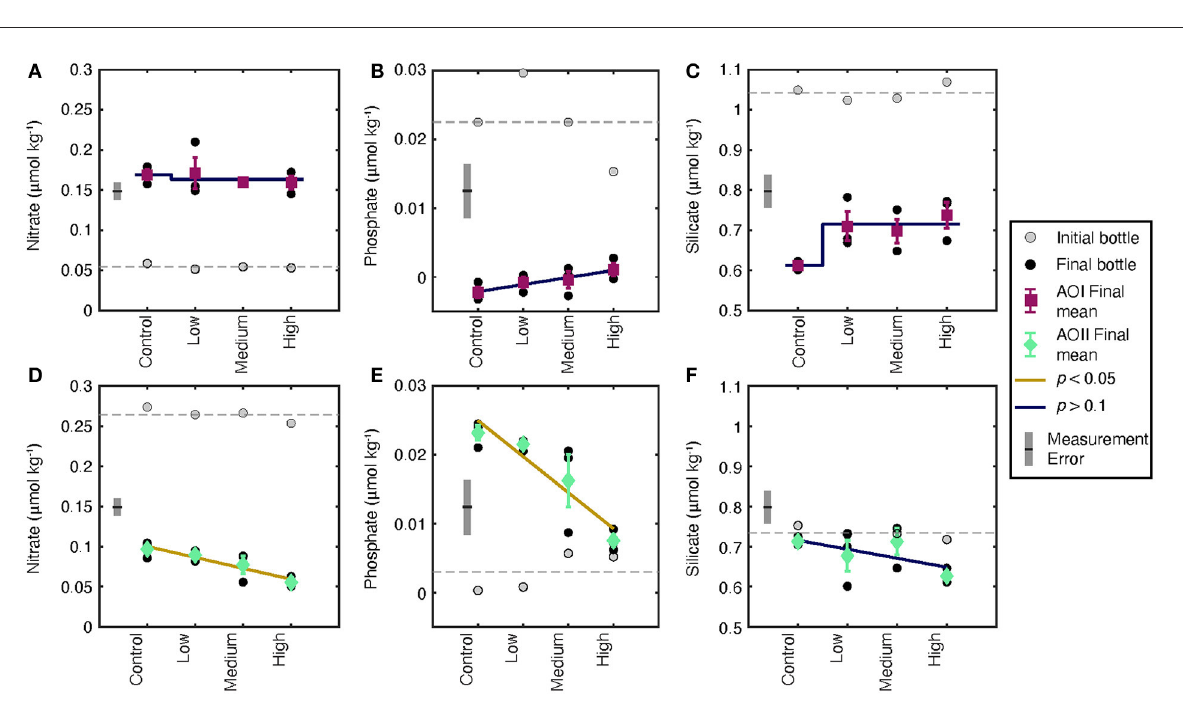
FIGURE4 Dissolved nitrate, phosphate, and silicate concentrations for t f (black circles)and t 0 (gray circles) at AOI (A–C) and AOII (D–F) . The gray dashed line indicates the mean value of all t 0 values. Each black circle is an individual experiment. Triplicate incubations for each condition are grouped, and the mean and standard deviation of the triplicates is shown as the colored symbol with error bars. Measurement errors determined from long-term repeat measurements over the cruise duration are shown as gray error bars. The trend shown is either a linear or step-change regression through the data. A blue line indicates an insignificant trend ( p > 0.1, or within measurement error); a gold line indicates a significant trend ( p <